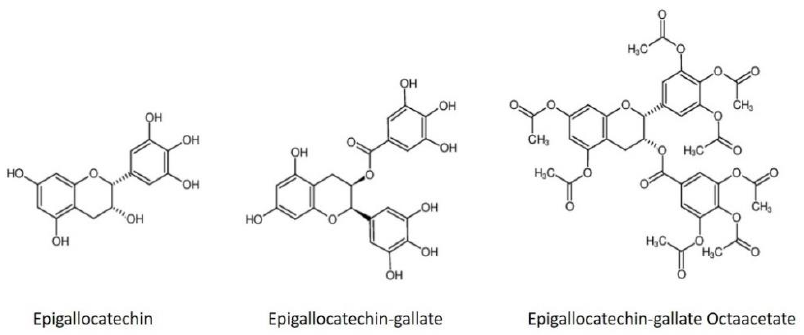
Figure 1. Structure of green tea catechins and their synthetic derivatives. Epigallocatechin, epigallocatechin gallate, and epigallocatechin gallate octaacetate.